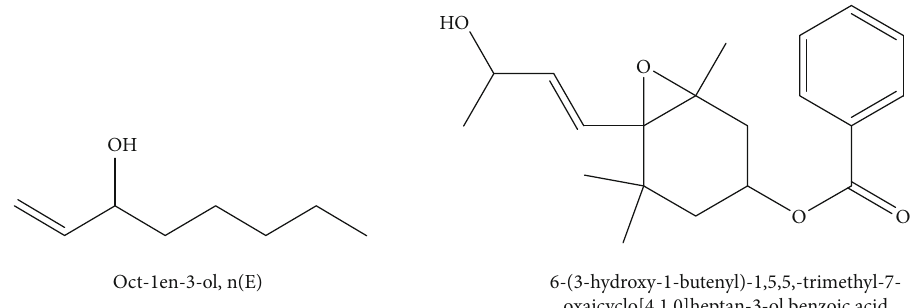
Figure 7: Major volatile oils from P. lanceolata L.